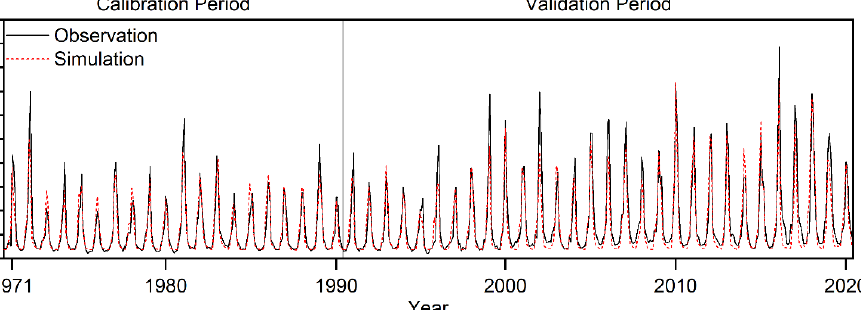
Figure 5. Simulated and observed monthly runoff for the calibration period from 1971 to 1990 and the validation period from 1991 to 2020.